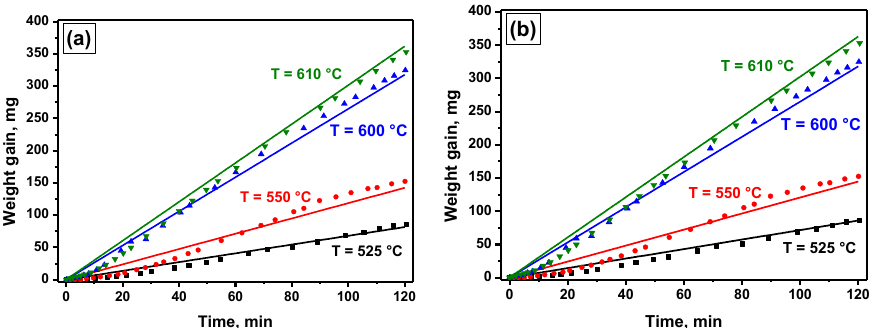
Figure 10. Kinetic modelling of the carbon deposition at various temperatures: ( a ) model D1a ; ( b ) model M1a . Experimental data are shown by symbols, while modelling results are presented by solid lines.